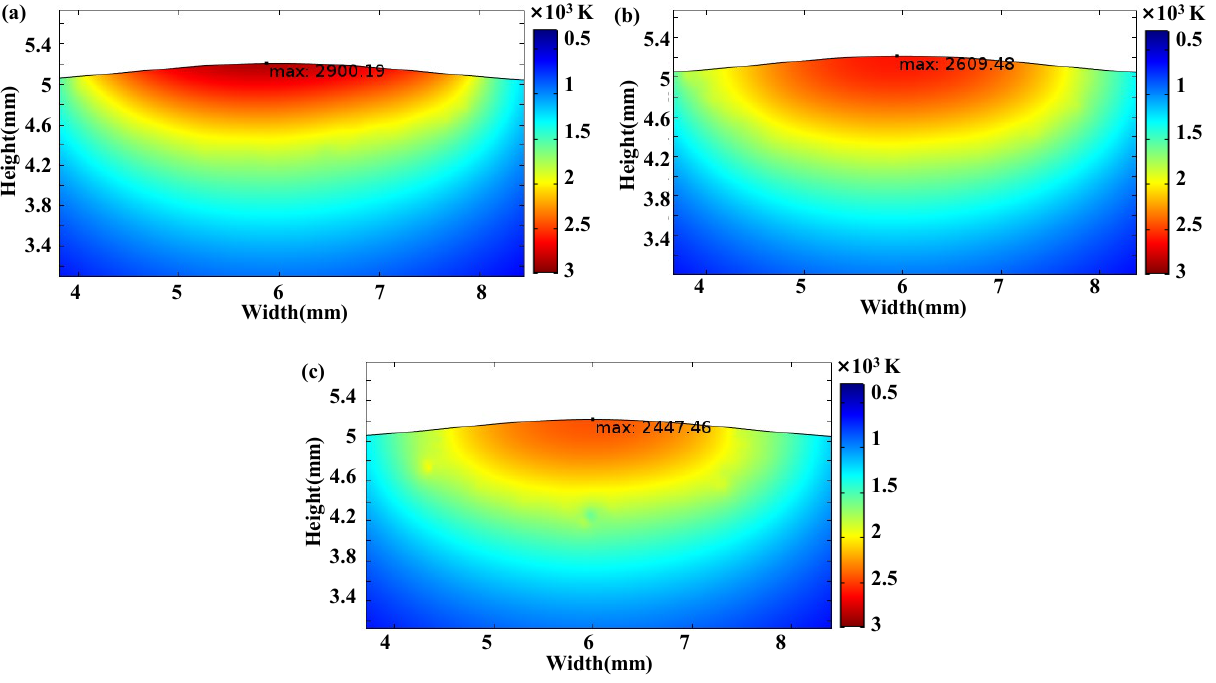
Figure 4. Temperature fields in the cooling process at the same time: ( a ) without vibration; ( b ) with 1D vibration; ( c ) with 2D vibration. The temperature of the substrate decreased when the laser beam moved away. The cooling processes were influenced by the vibration, and the results are shown in Figure 4. When the laser beam moved away for 0.1 s, the maximum temperatures were 2900.19 K, 2609.48 K and 2447.46 K at the conditions without vibration, with 1D vibration and 2D vibration, respectively. It indicated that the convective heat flux and the cooling rate were